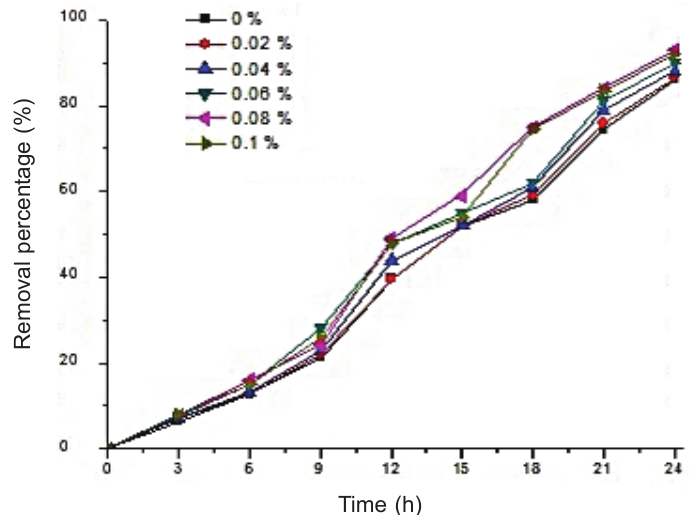
Fig. 6 – Effect of yeast extract on the phenol degradation of strain